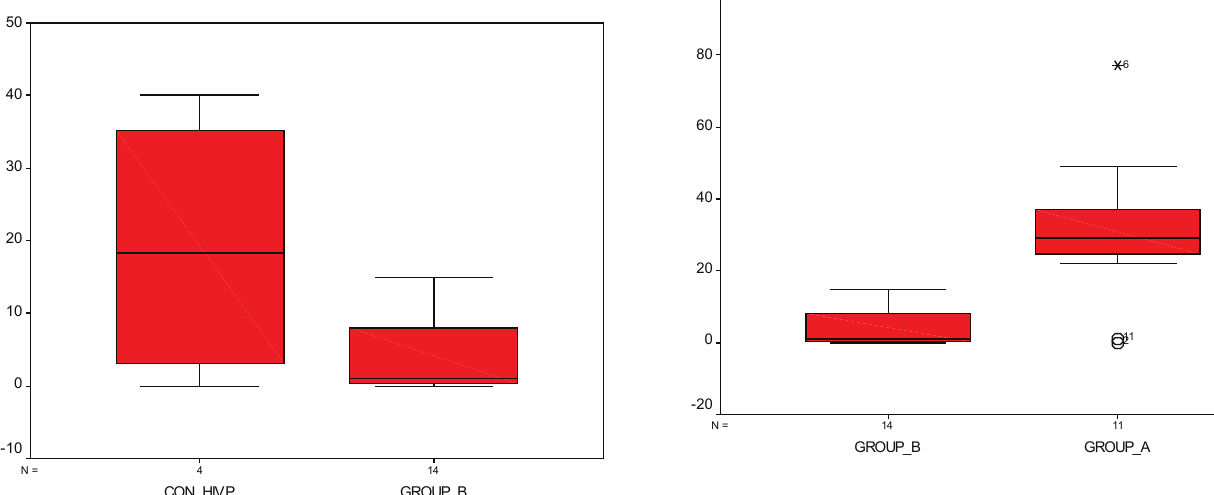
FIGURE 5 – Boxplot – Comparison between Langerhans